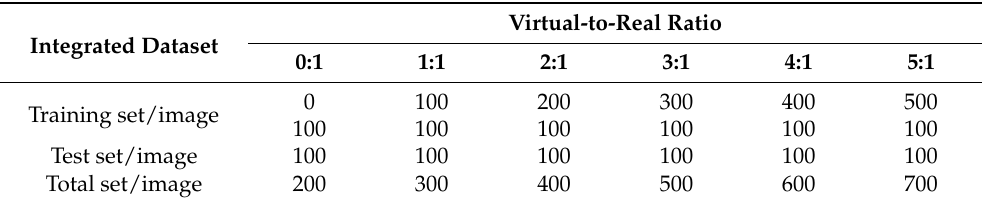
Table 2. Integrated datasets with different virtual-to-real ratios. Integrated